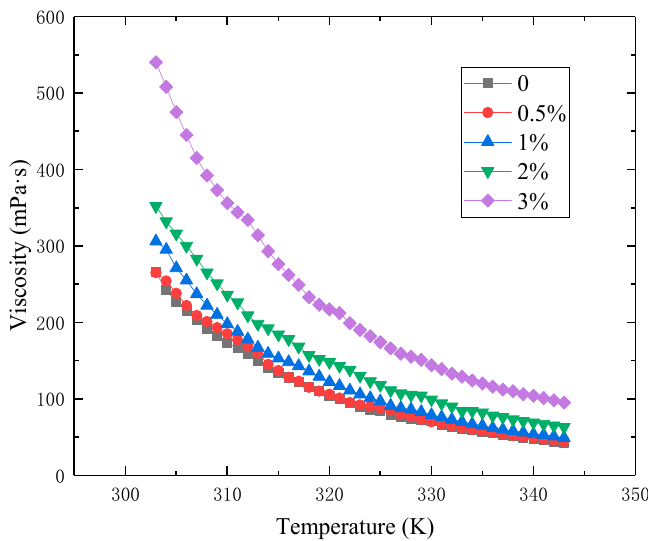
Figure 6. Viscosity of prepared nanofluid samples at different temperatures.